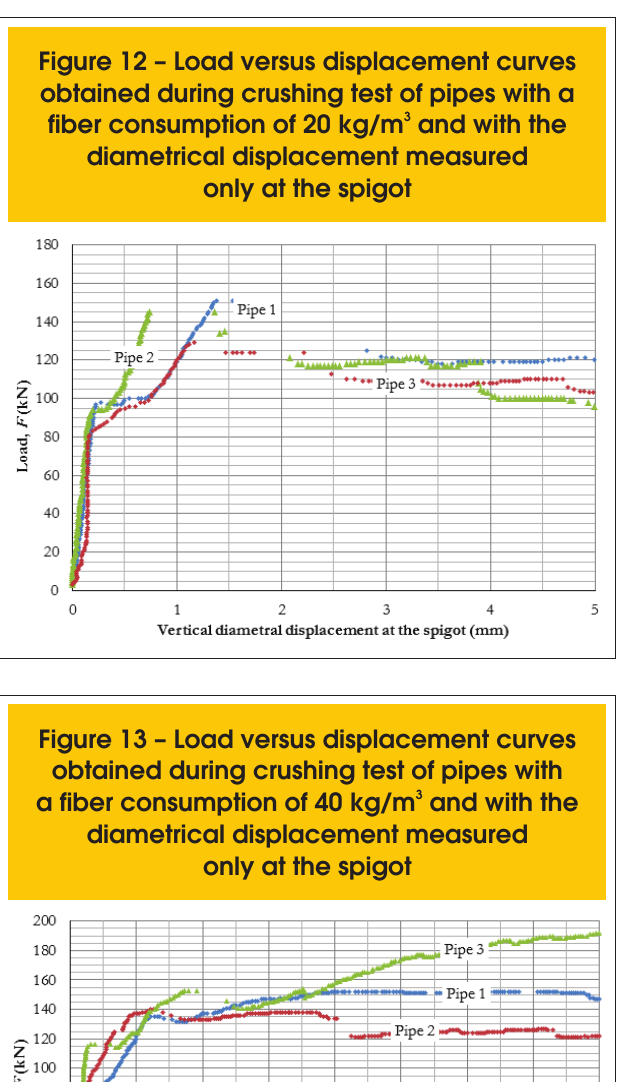
Figure 15 – Average load versus diametrical displacement curves of pipes tested st in the 1